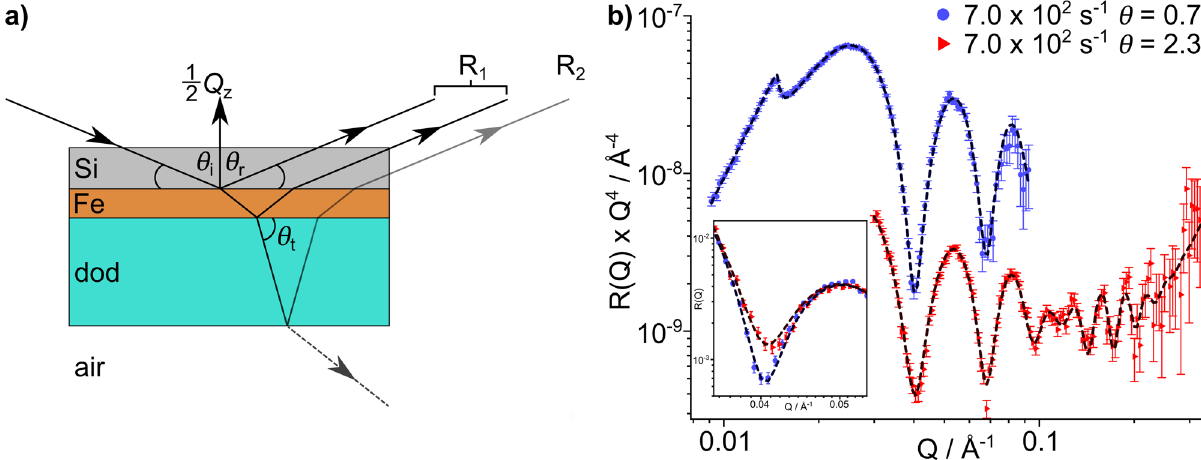
Figure 5. Depiction of reflectivity arising from the non-sheared portion of the interface and the best fit to the NR data collected with dodecane- d 26 at 7.0 × 10 2 s − 1 . ( a ) Schematic of thick film reflectivity. R 1 is the reflectivity term that accounts for reflection from the immediate Si interface. Neutrons transmitted over the immediate interface will propagate through dodecane at an angle θ t before being either reflected or transmitted at the dodecane–air interface. R 2 is the reflectivity term that accounts for reflection from the dodecane–air interface. ( b ) The best fit, shown by dashed lines, to the NR data collected with dodecane- d 26 entrained against an iron- coated silicon substrate at 7.0 × 10 2 s − 1 . The reflectivity has been modified by a Q 4 factor to aid comparison. The data collected at θ = 2.3 ◦ is offset by 10 − 1 in the vertical axis. The insert shows the unadjusted reflectivity at the first fringe minimum.